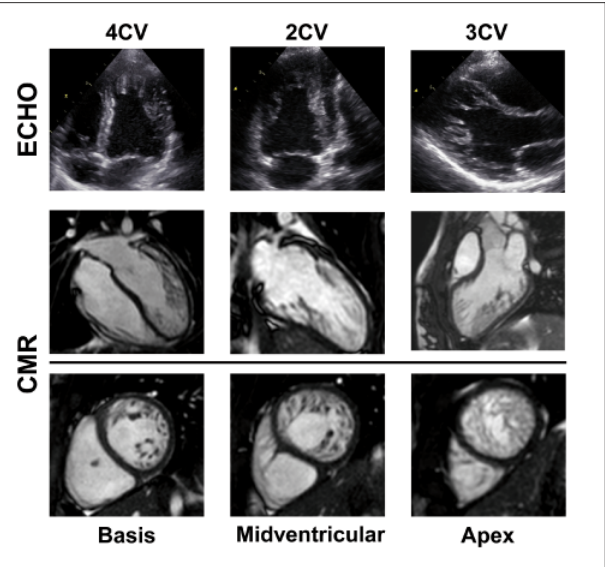
Figure 2. Echocardiography and cardiovascular magnetic resonance (CMR) imaging in left ventricular noncompaction (LVNC) of a 14-year-old girl with LVNC. The upper and middle panel show 4, 2, and 3 chamber views (CV) of representative echocardiographic and CMR images, respectively. The lower panel depicts the CMR short axis view at the basis, midventricular site, and apex of the same heart.